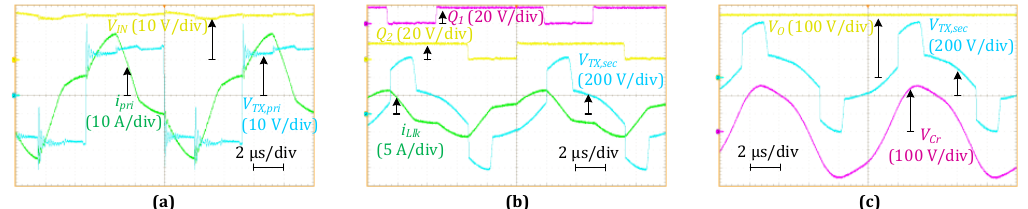
Figure 10. Waveforms of the studied topology with the overlapping PWM at P IN = 300 W and V IN = 25 V: ( a ) front-end inverter; ( b ) bridgeless rectifier; ( c ) output and resonant capacitor voltage.